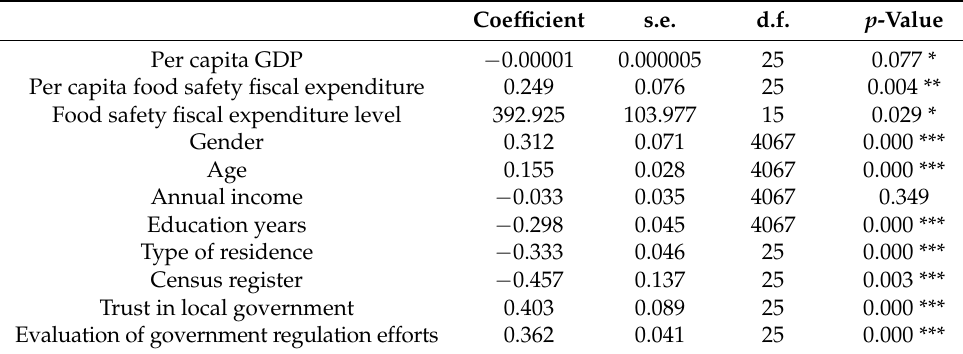
Table 5. Regression results of the complete